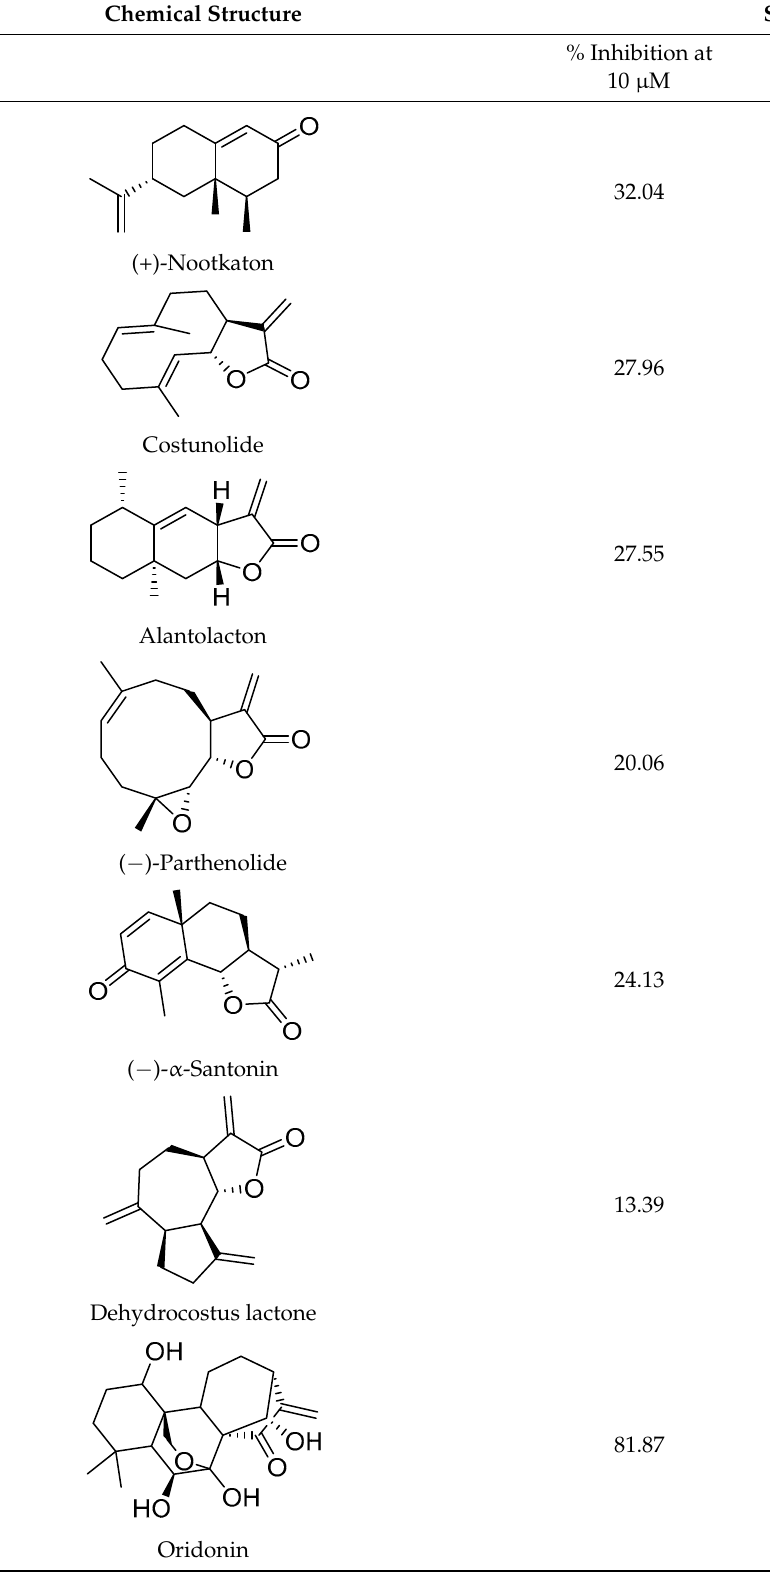
Table 1. Inhibition of SARS-CoV-2 M pro by natural and synthesized